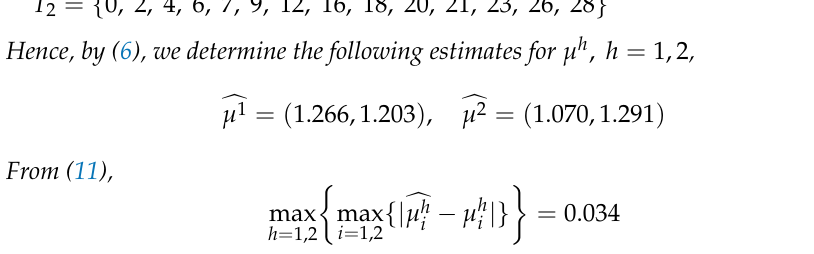
and (cid:99) µ 2 , i = 1,2, in the successive generations belonging to T 1 i i